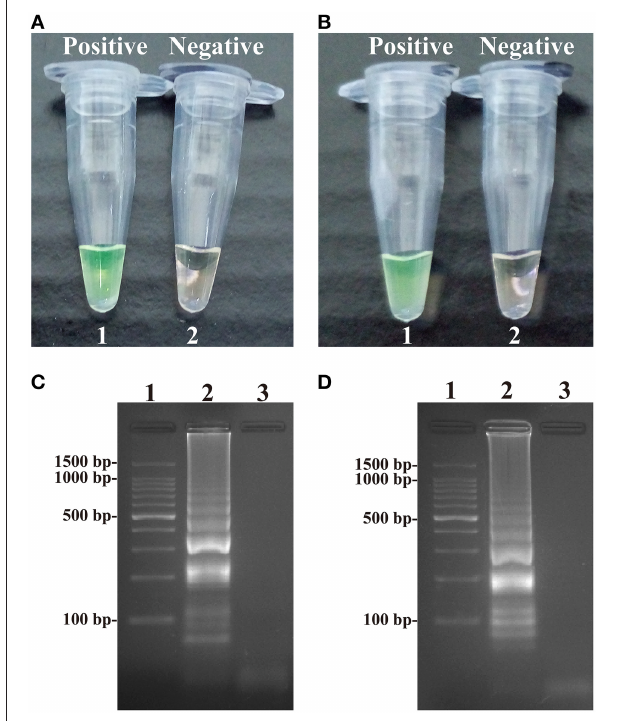
FIGURE 3 | Detection and confirmation of Salmonella - and Shigella -MCDA products. (A,B) Color change of Salmonella - and Shigella -MCDA tubes; tube 1, positive amplification; tube 2, negative amplification. (C,D) 2% agarose gel electrophoresis applied to Salmonella - and Shigella -MCDA products; lane 1, DL 100-bp DNA marker; lane 2, positive MCDA reaction, lane 3, negative MCDA